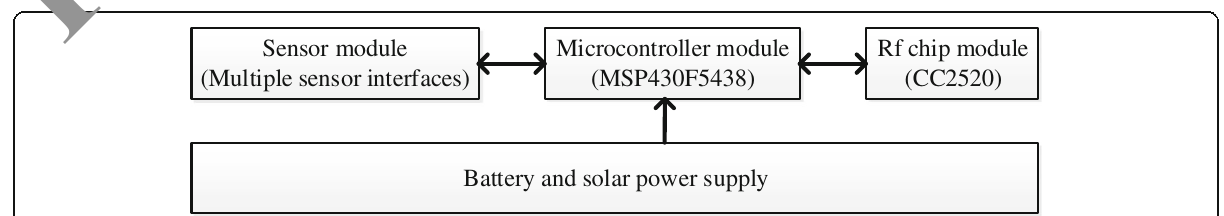
Fig. 2 Structure block diagram of the wireless sensor